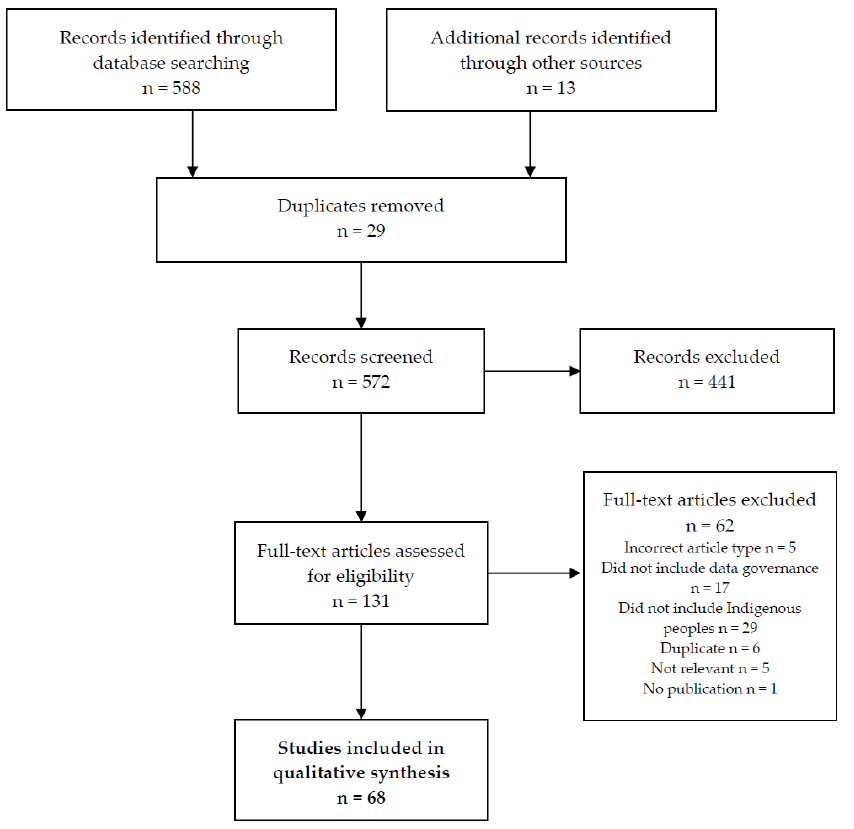
Figure 1. PRISMA screening process to assess Indigenous Data Governance in health